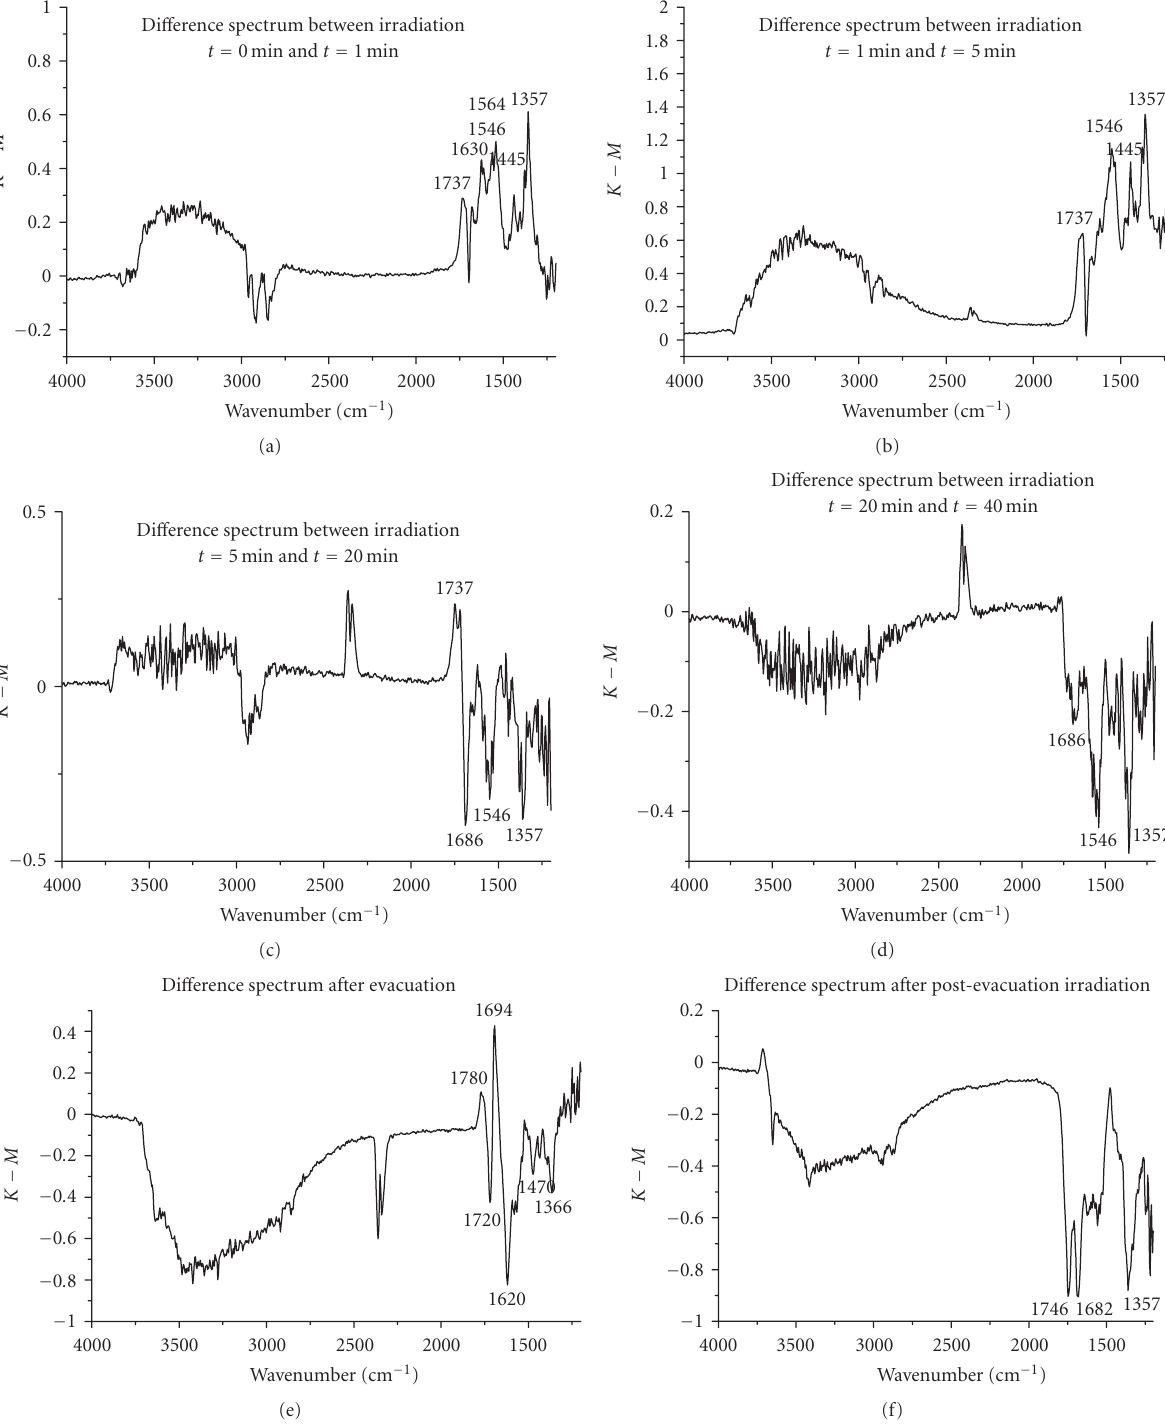
Figure 6: Time series DRIFT di ff erence spectra following course of decane